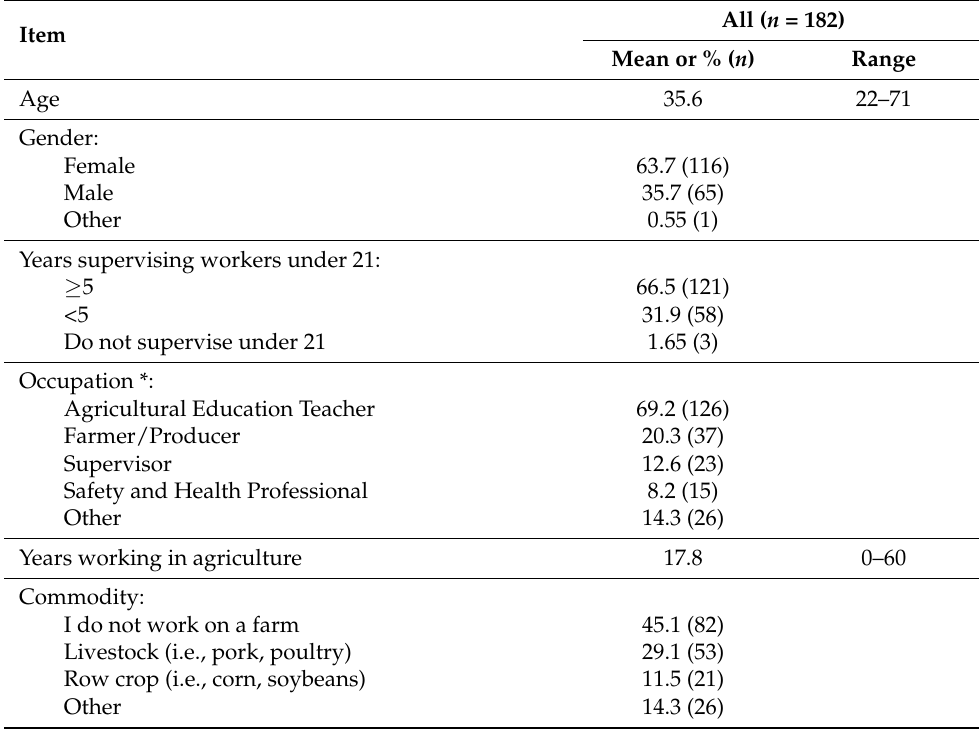
Figure 1. U.S. States with training participants, n = 182. States with no shading (white) had no participants. Darker shading represents a greater number of participants. Participants from Canada and U.S. territories are not included in the figure. Table 2. Demographic and workplace